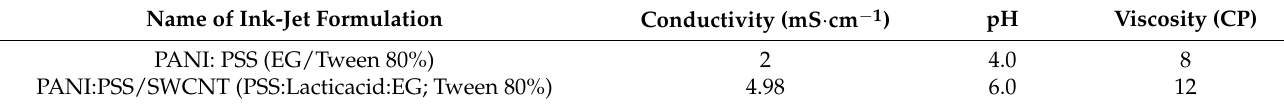
Table 9. Ink Jet solutions properties.